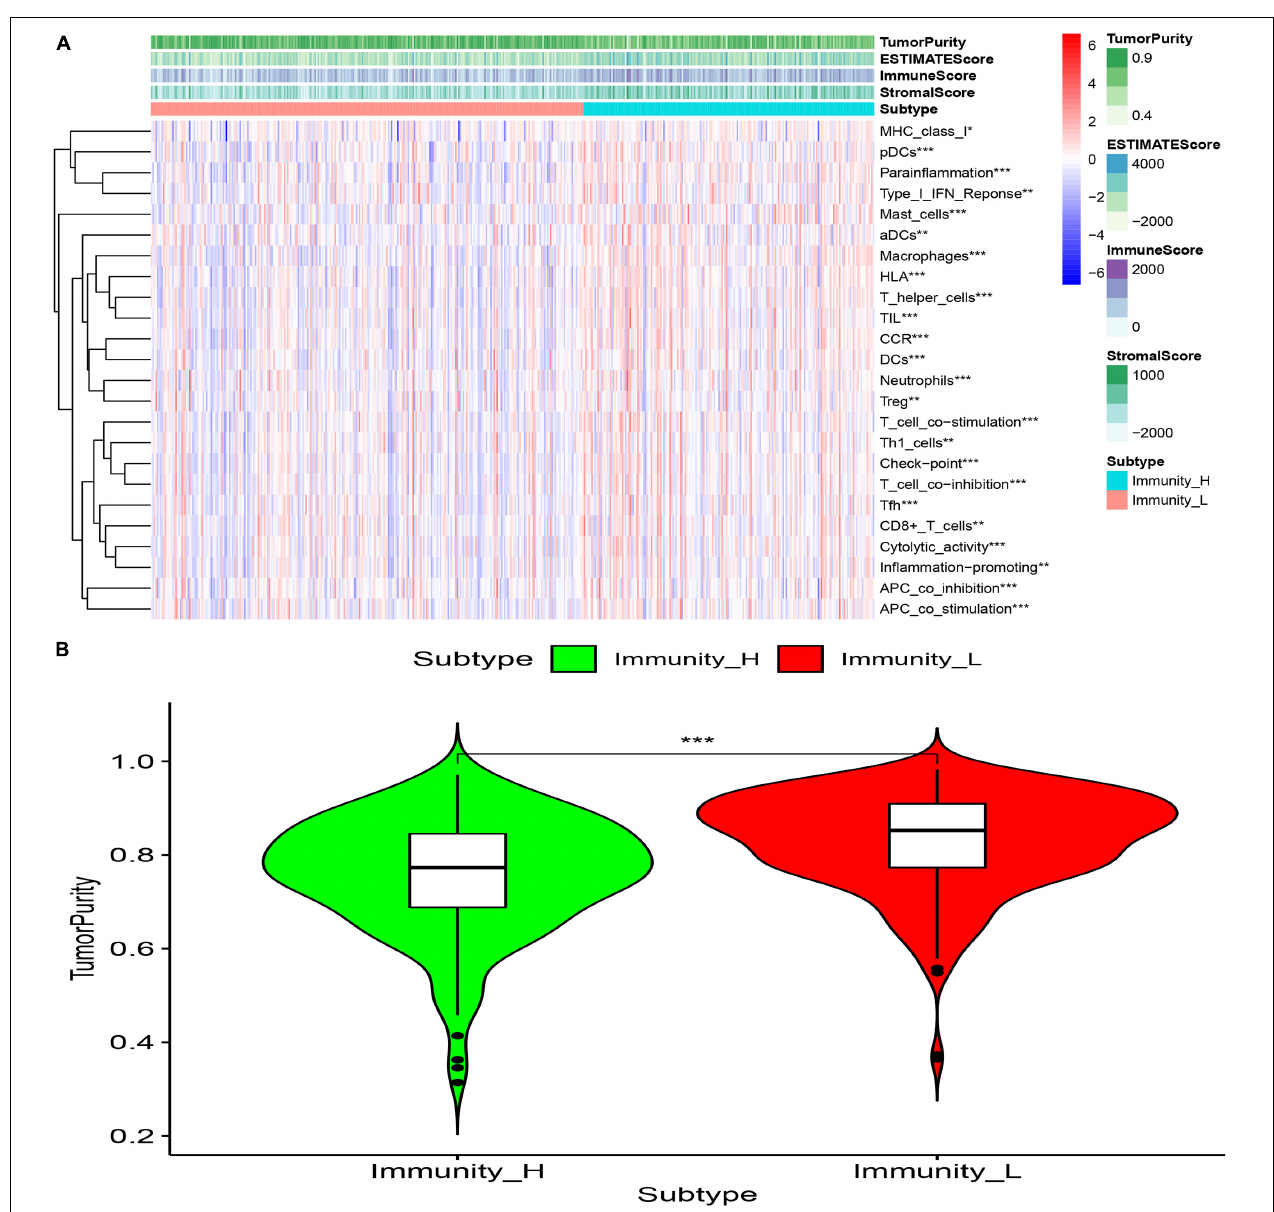
FIGURE 5 | (A) Compared with the low immune score group, high immune array Stromal Score, Immune Score, ESTIMATE Score were higher (* p < 0.05; ** p < 0.01; *** p < 0.001). (B) Compared with the low immune score group, the tumor purity of the high immune array was significantly reduced (*** P <